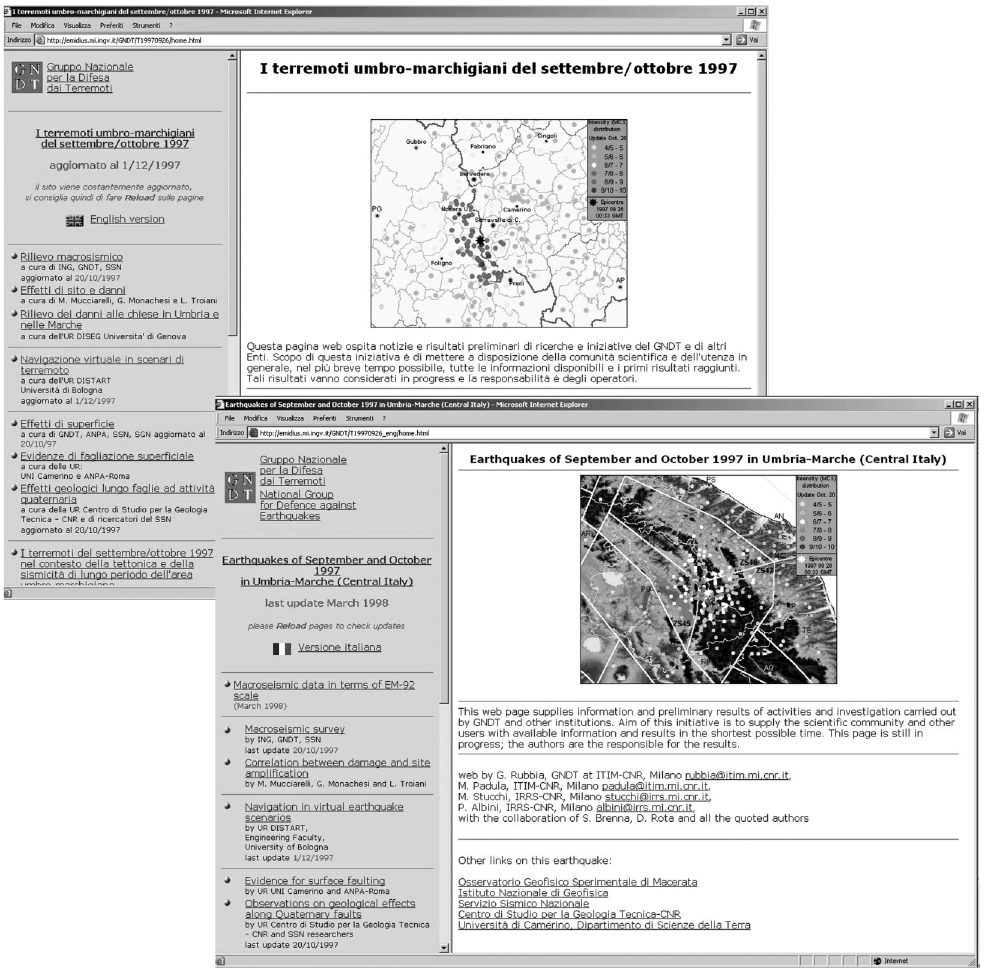
Fig. 3. Homepages of the Italian and English version of the GNDT web site dedicated to the Umbria-Marche seismic